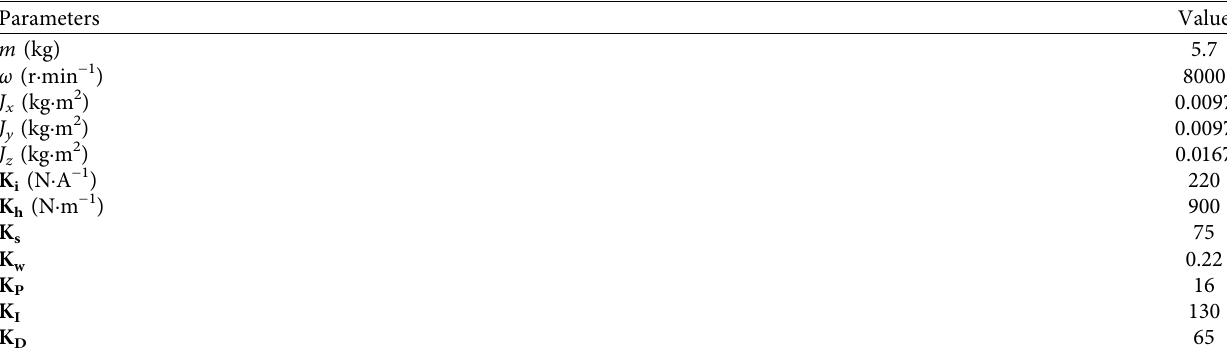
Table 1: The main parameters of the control